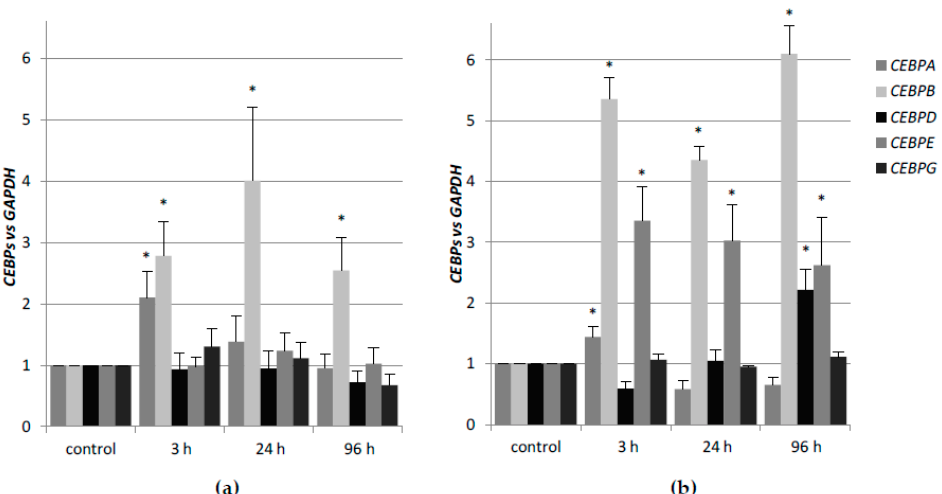
Figure 1. Regulation of CEBP genes in HL60 exposed to 1,25D or all- trans -retinoic acid (ATRA). HL60 cells were exposed to 10 nM 1,25D ( a ) or 1 µ M ATRA ( b ) and after desired time the expression of CEBP genes was measured by Real-time PCR. The bars represent mean values ( ± standard error of the mean (SEM)) of the fold changes in mRNA levels relative to glyceraldehyde 3-phosphate dehydrogenase ( GAPDH ) mRNA levels. Expressions in control cells were treated as calibrators. Values significantly different from those obtained from respective controls cells are marked with an asterisk (* p < 0.05).